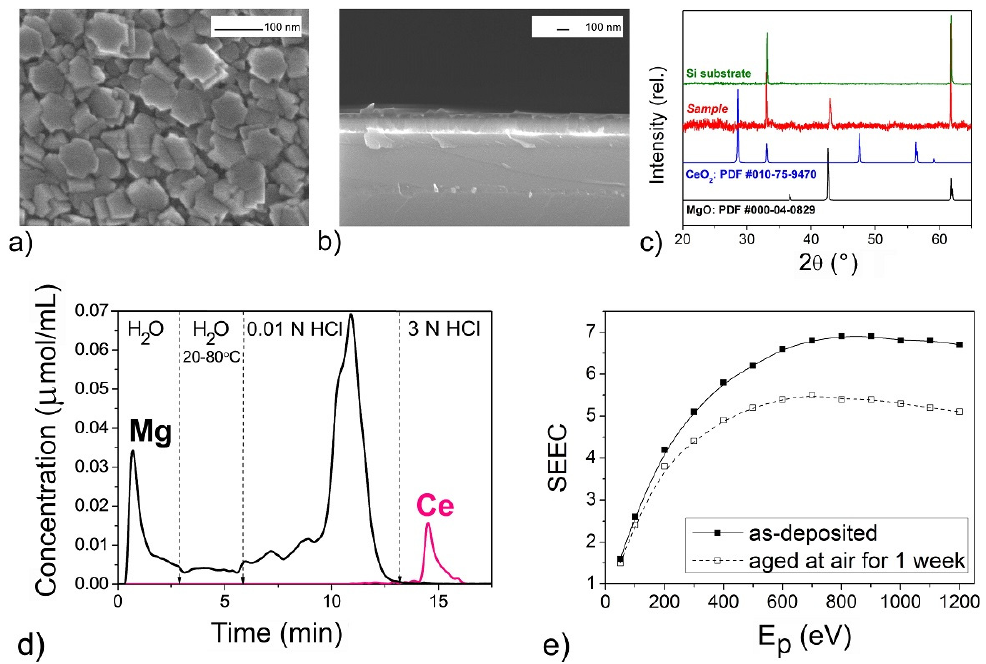
Figure 6. The mixed oxide film with n(Mg):n(Zr) = 10:1 according to DD data: SEM images ( a , b ), XRD pattern ( c ) DD curves ( d ), SEEC (Ep) curves ( e ).